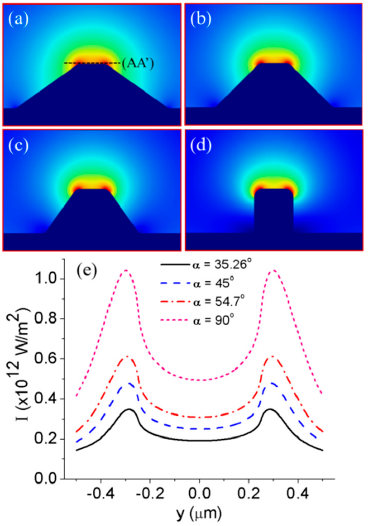
Figure 3. The normalized electric field distributions of the WPP modes on the cross–section of the wedge SPP waveguides for various sidewall corners: ( a ) α = 35.26 ◦ , ( b ) 45 ◦ , ( c ) 54.7 ◦ and( d ) 90 ◦ ; and ( e ) the distributions of the light intensity along the AA’ cut